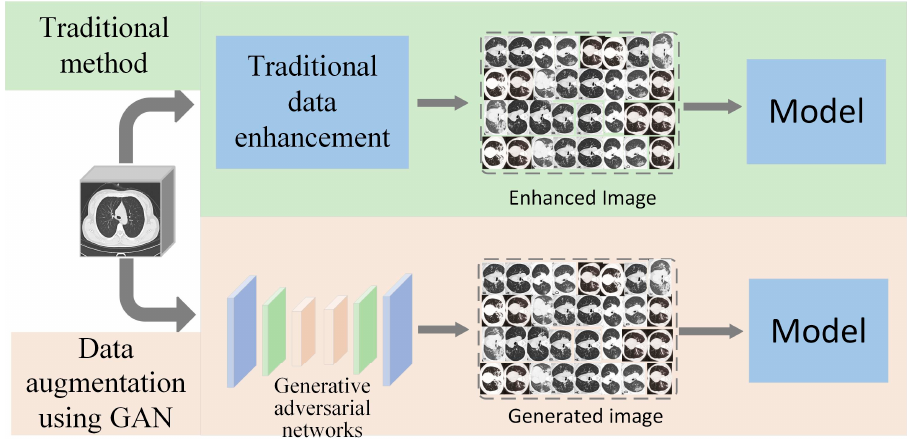
Figure 5. Data augmentation methods.